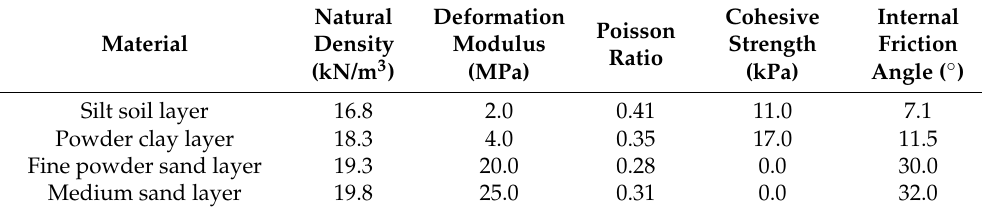
Table 2. Soil layer material